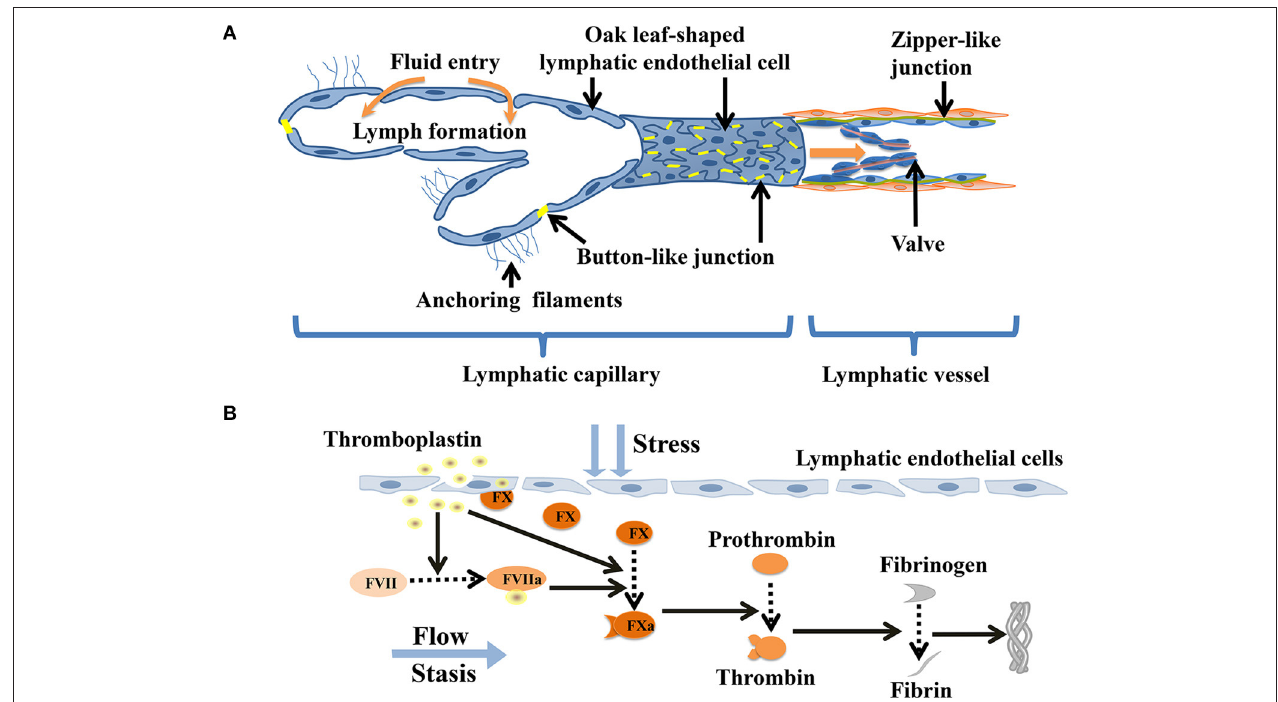
FIGURE 1 | Coagulation in lymphatic vessels. (A) Schematic diagram indicating the lymphatic capillaries with oak leaf-shaped endothelial cells and discontinuous button-like junctions. The collecting lymphatic vessels have continuous zipper-like junctions and lymphatic muscle cellscoveragewhich contract and act as intrinsic lymphatic pump, hence facilitating lymph flow. (B) Thromboplastin (tissue factor) stimulates damaged lymphatic endothelial cells toreleasefactor X and actives factor VII. Factor X is activated by factor VII-thromboplastin complexes and thromboplastin. Activated factor X helps to convert prothrombin to thrombin, which facilitates theconversion of fibrinogen intofibrin. Eventually, the fibrin mesh forms a dense fibrous protein mass that may cause a large number of embolisms of lymphoid cells.